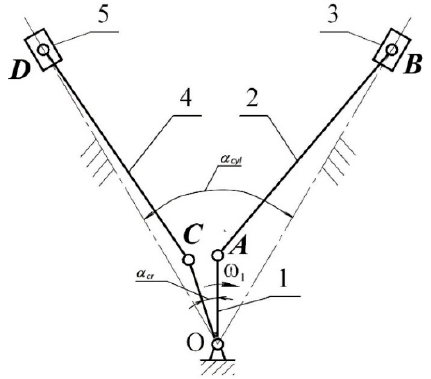
Figure 7. ( a ) Kinematic scheme of V-shaped ICE: 1—crankshaft, 2 and 4—couplers, 3 and ( a ) Kinematic scheme of V-shaped ICE: 1—crankshaft, 2 and 4—couplers, 3 and 5—pistons [26]. Figure is reprinted with permission from publisher. 5—pistons [26]. Figure is reprinted with permission from